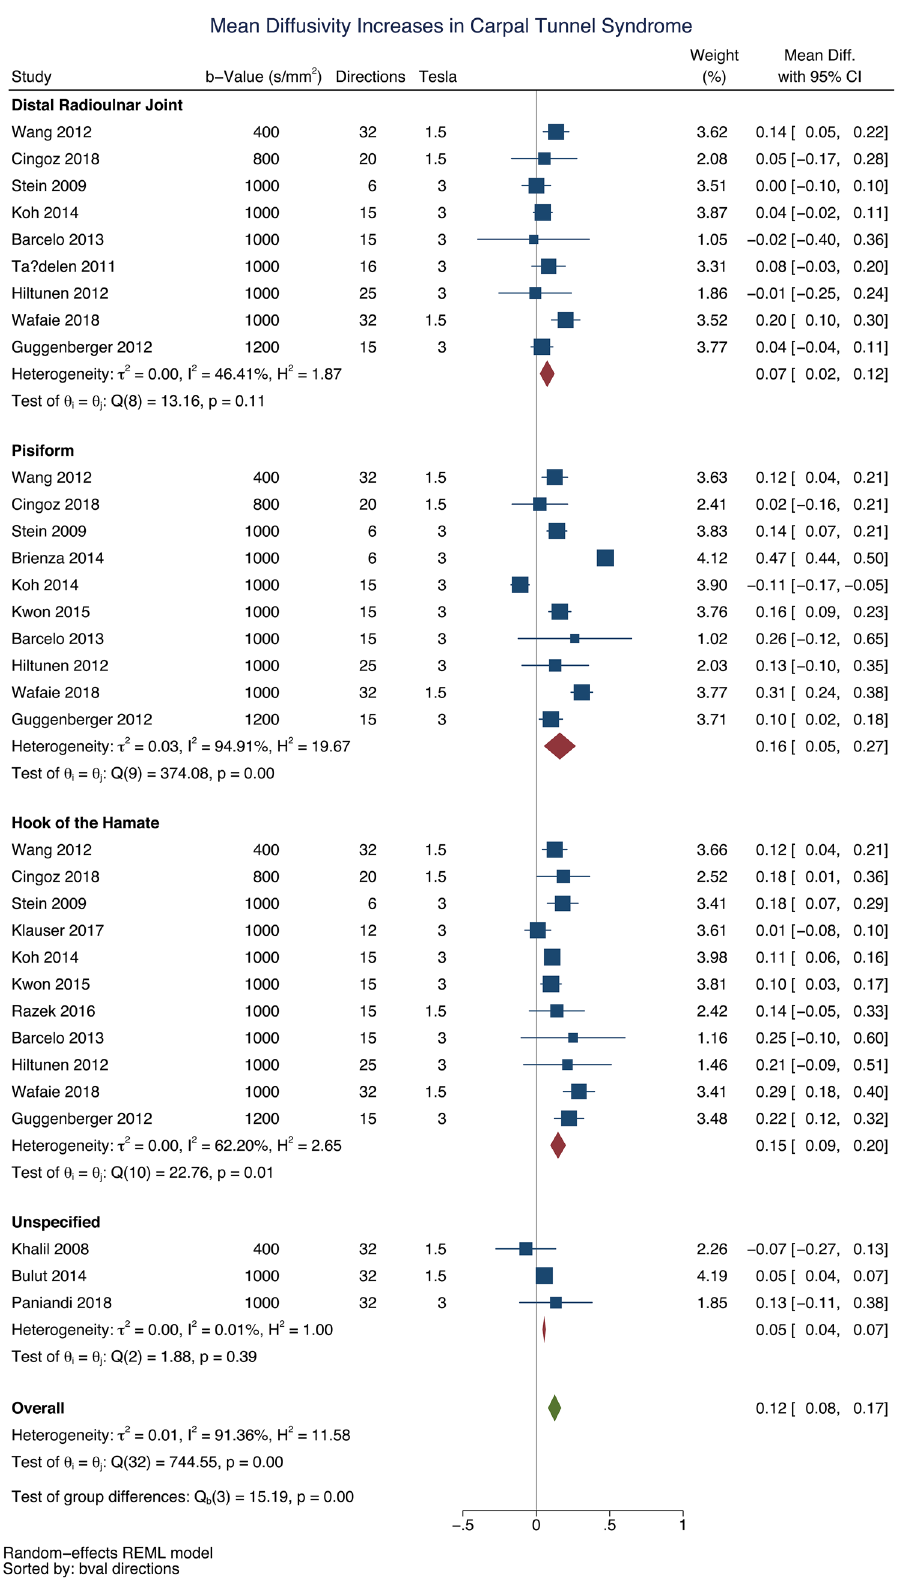
Figure 3. A forest plot of the mean diffusivity of the median nerve, at 3 anatomical levels, between asymptomatic adults and patients with carpal tunnel